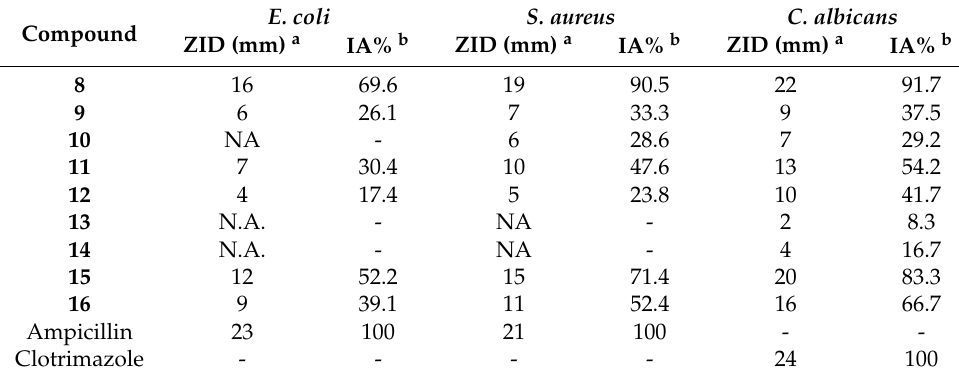
Table 2. The antimicrobial properties of the OSe compounds. Compound